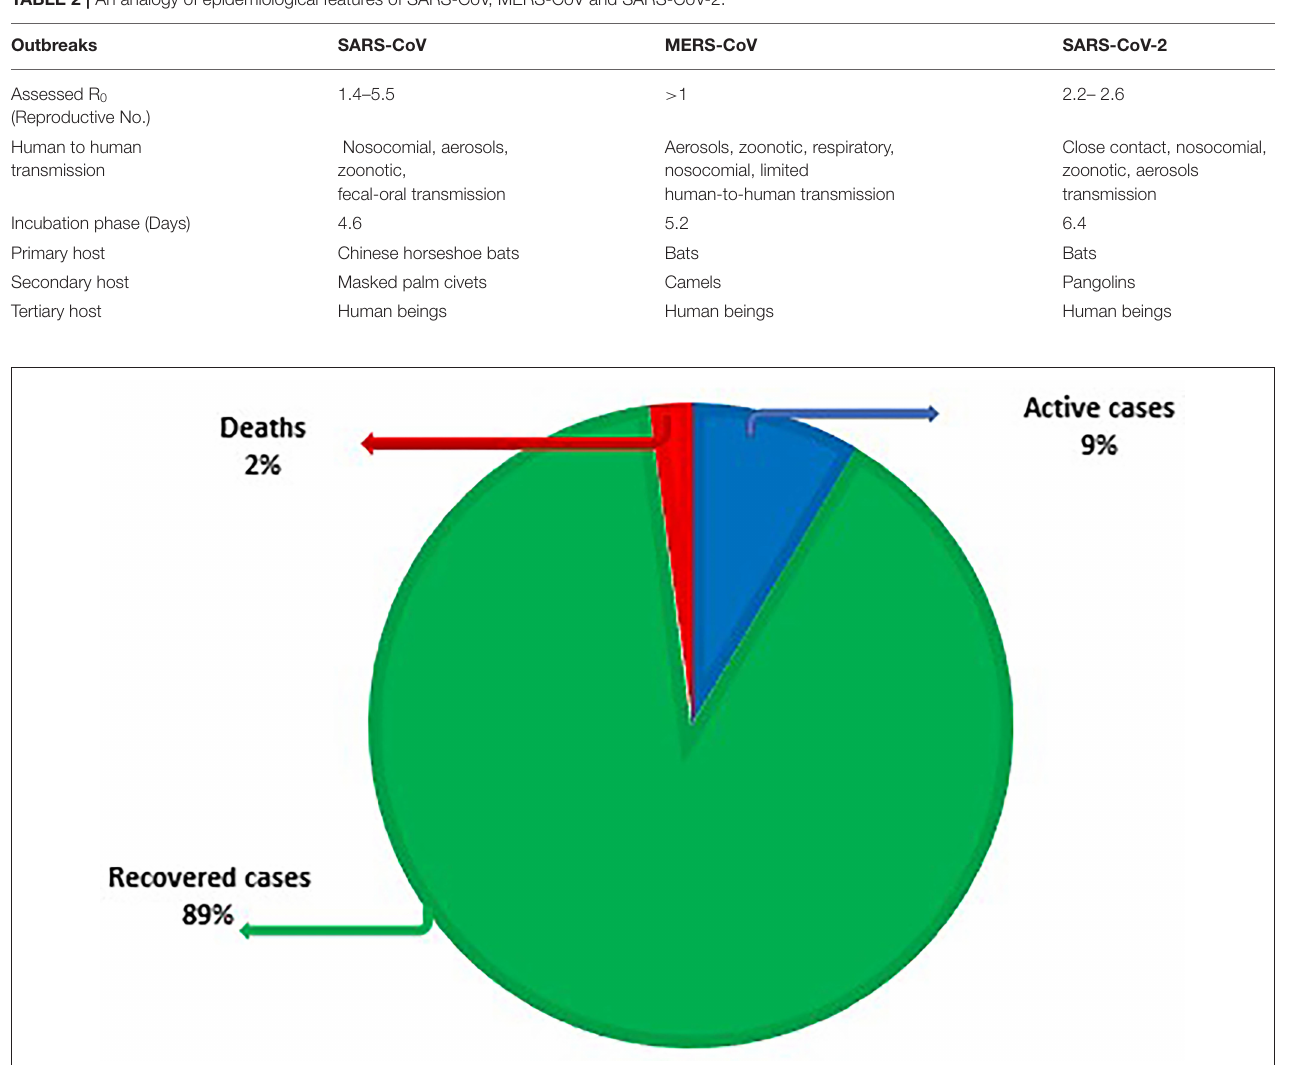
TABLE 2 | An analogy of epidemiological features of SARS-CoV, MERS-CoV and SARS-CoV-2.